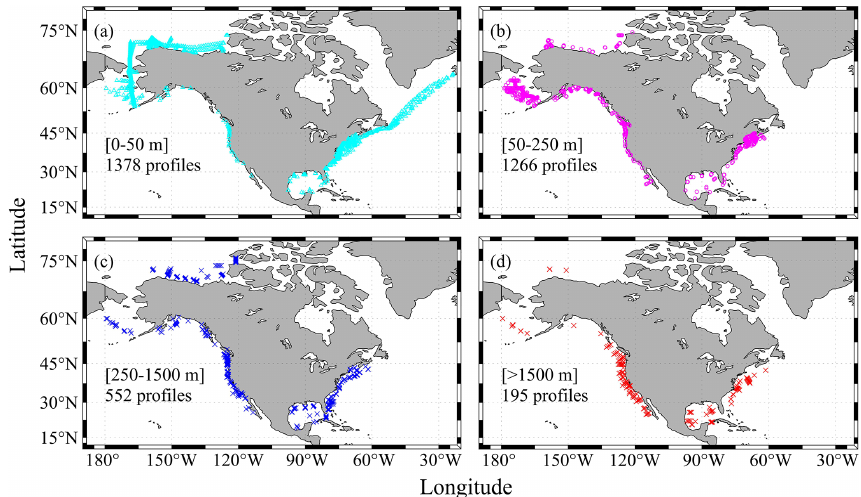
Figure 4. Sampling depths of the profiles: (a) profiles with maximum depths ranging from 0 to 50m, (b) profiles with maximum depths ranging from 50 to 250m, (c) profiles with maximum depths ranging from 250 to 1500m, and (d) profiles with maximum depths greater than 1500m.